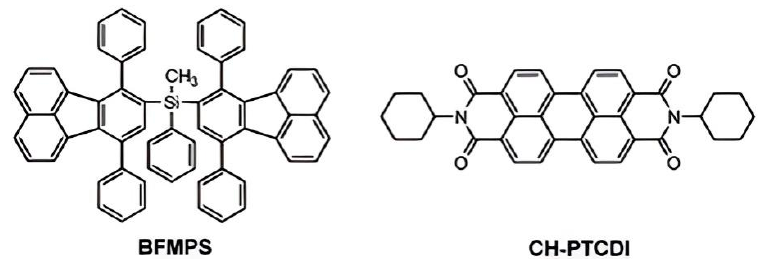
Figure 1. Molecular structures of BFMPS and CH-PTCDI [22] . Copyright 2013, RSC publishing.